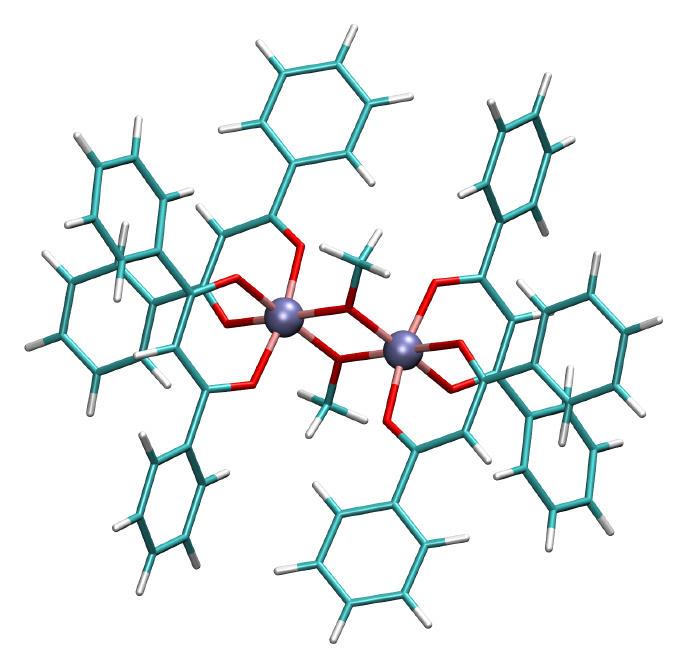
Figure 1. Fe 2 (OCH 3 ) 2 (dbm) 4 X-ray structure. Fe, O, C, and H atoms are blue, red, green, and white colored,